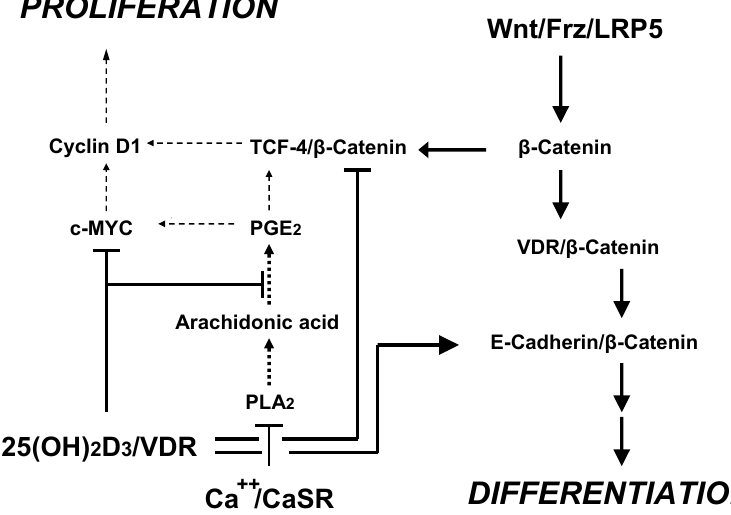
Figure 3. Cooperative signaling from Ca 2+ /CaSR and 1,25-(OH) pathways inhibits proliferation and promotes differentiation of colonocytes and of colorectal cancer